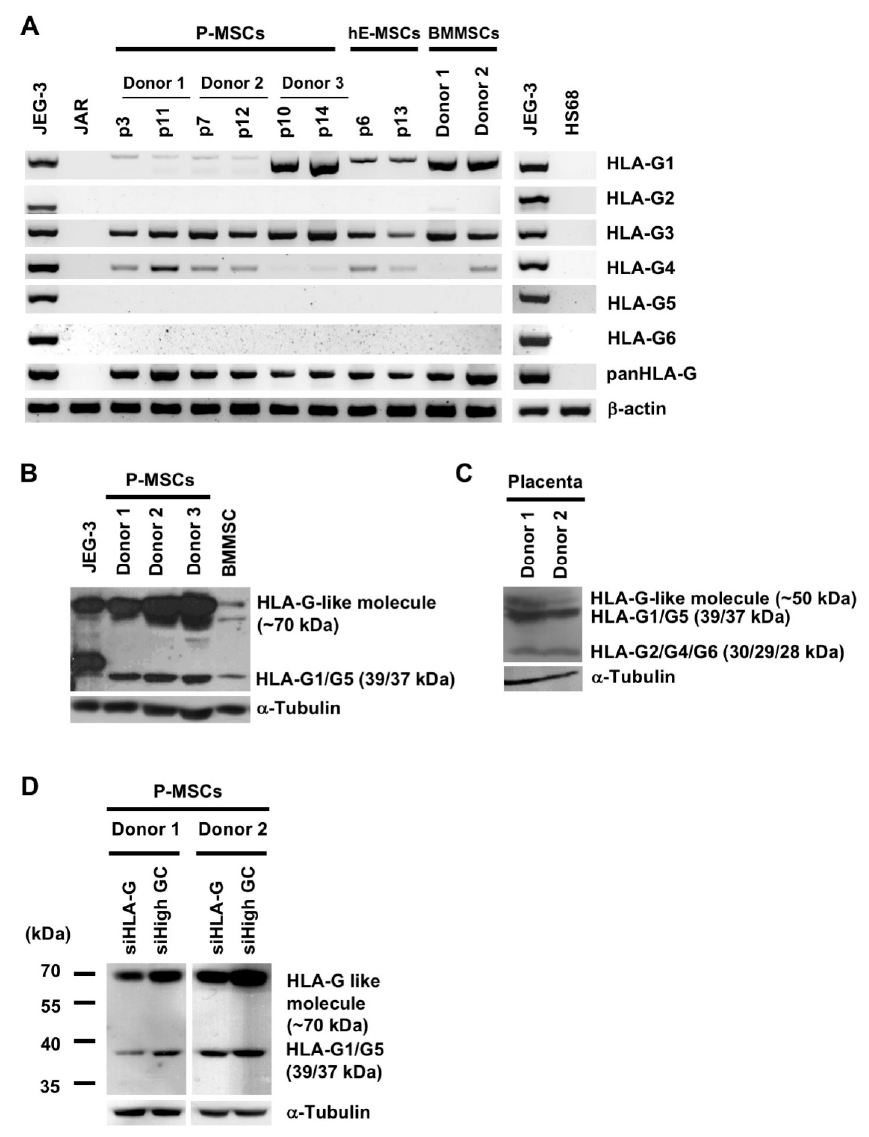
Figure 1. Diverse sources of human mesenchymal stem cells (MSCs) but not fibroblasts express multiple HLA ‐ G mRNA and protein isoforms. ( A ) Expression of HLA ‐ G mRNA variants in JEG ‐ 3 HLA-G mRNA and protein isoforms. ( A ) Expression of HLA-G mRNA variants in JEG-3 cells, JAR cells, JAR cells, human placenta ‐ derived MSCs (P ‐ MSCs), human embryonic stem cell ‐ derived MSCs cells, human placenta-derived MSCs (P-MSCs), human embryonic stem cell-derived MSCs (hE-MSCs), (hE ‐ MSCs), bone marrow (BM) MSCs, and HS68 fibroblast cell line as analyzed by nested RT ‐ PCR; bone marrow (BM) MSCs, and HS68 fibroblast cell line as analyzed by nested RT-PCR; “p” denotes “p” denotes passage number. ( B ) Expression of HLA ‐ G protein isoforms in JEG ‐ 3 cells, P ‐ MSCs, passage number. ( B ) Expression of HLA-G protein isoforms in JEG-3 cells, P-MSCs, BMMSCs, and BMMSCs, and ( C ) human term placenta extract as detected by Western blot analysis ( α‐ tubulin, ( C ) human term placenta extract as detected by Western blot analysis ( α -tubulin, internal control). internal control). ( D ) P ‐ MSC (2 donors) expression of HLA ‐ G protein isoforms after RNA silencing of ( D ) P-MSC (2 donors) expression of HLA-G protein isoforms after RNA silencing of HLA-G with small HLA ‐ G with small interfering RNA specific for HLA ‐ G (siHLA ‐ G) or non ‐ target siRNA (siHigh GC), interfering RNA specific for HLA-G (siHLA-G) or non-target siRNA (siHigh GC), as measured by Western blot analysis ( α -tubulin, internal